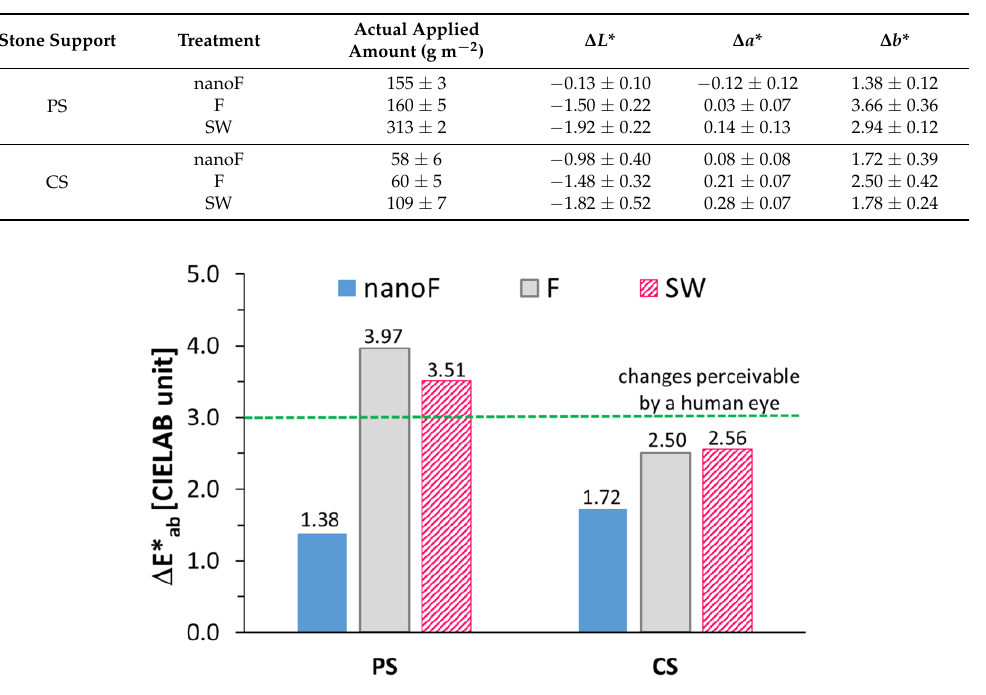
Figure 4. Differences in c olor (Δ E * ab ) before and after the products’ application.